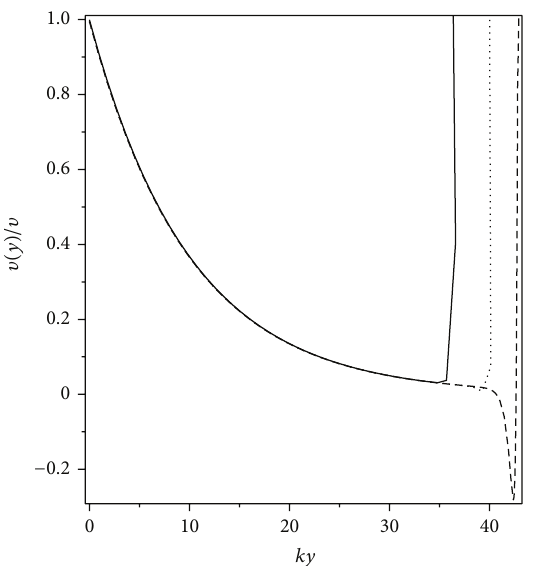
Figure 3: The VEV profile for negative induced brane cosmological constantwithpositivebranetensionfor ℵ = 33 (dottedline), ℵ = 34 (dashed line), and ℵ = ∞ (solid line, i.e., RS case) in the (𝐷,𝑁) case ̃𝜆 = 100 . The values of other parameters of the model are the for 𝐿 same as the ones in Figure